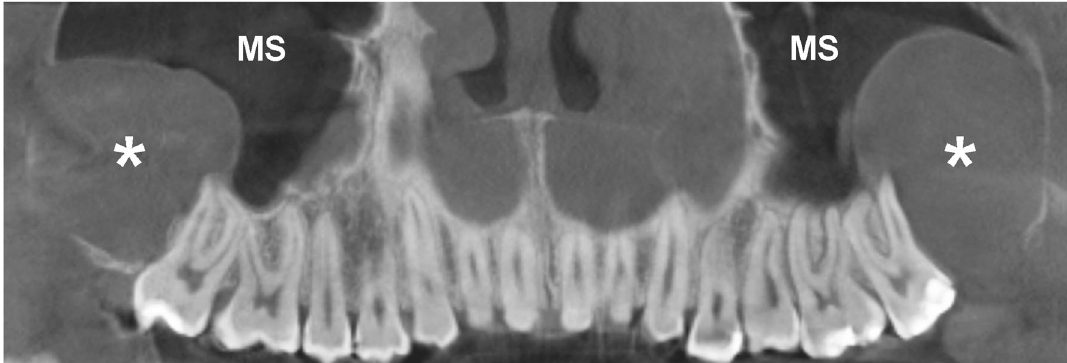
Fig. 16 Panoramic CBCT image (1 mm thick) shows two unilocular OKCs on both sides of the maxilla ( asterisks ) in a young male patient with nevoid basal cell carcinoma syndrome (NBCCS). Both lesions, located in the posterior sextants, extend into the maxillary sinuses ( MS